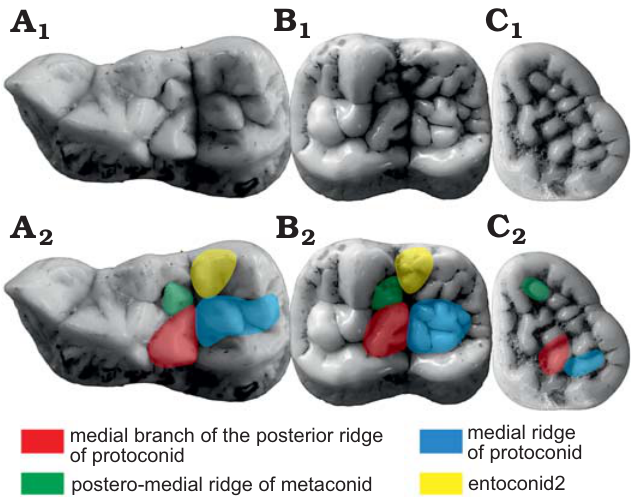
Fig. 14. Serial homology of lower molars (occlusal views) of Ailuropoda sp. ( A . IVPP V13459.10, B . IVPP V13459.91, C . IVPP V87025.362) from